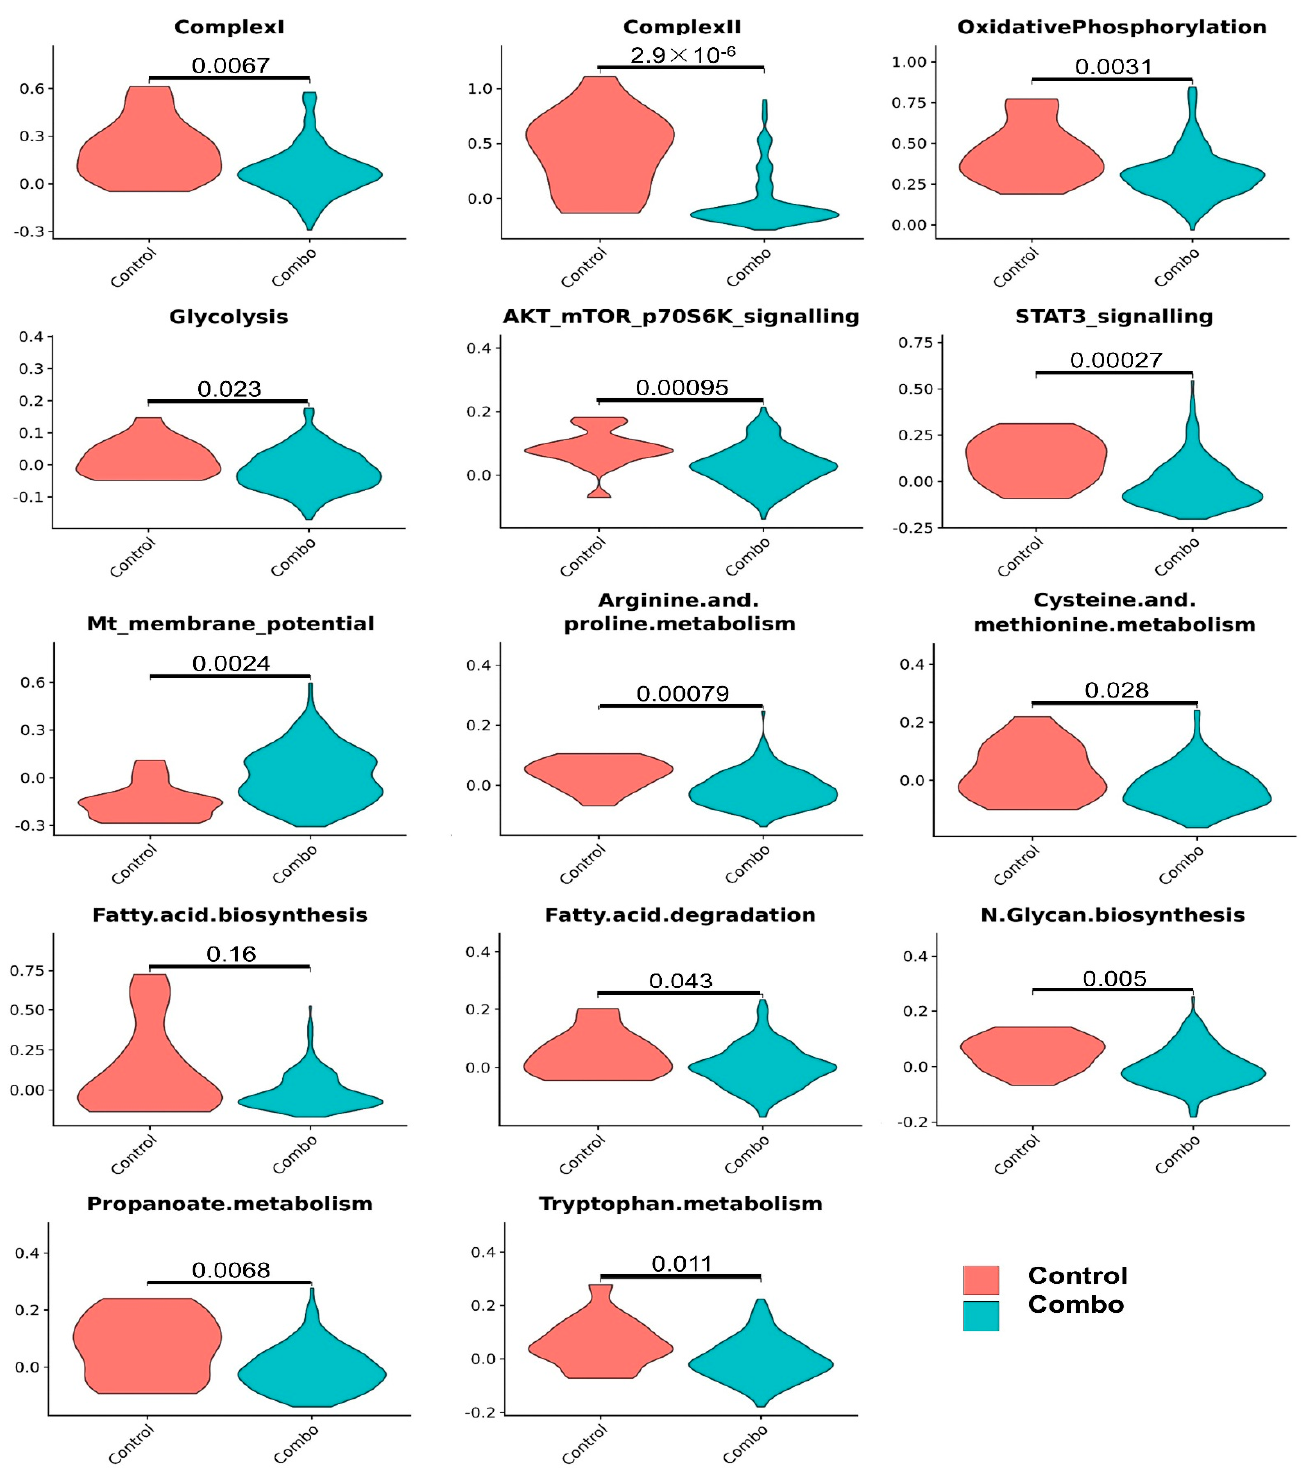
Figure 10. Significantly altered pathways in lung adenoma cells from mice given the combined treatment. In lung adenoma cells, the combined treatment decreased the activities of complex I, complex II, OXPHOS, glycolysis, AKT/mTOR/p70S6K signaling, STAT3 signaling, arginine and proline metabolism, cysteine and methionine metabolism, fatty acid metabolism, N-glycan biosynthesis, propanoate metabolism, and tryptophan metabolism. In contrast, combined treatment resulted in hyperpolarized mitochondrial membrane potential.